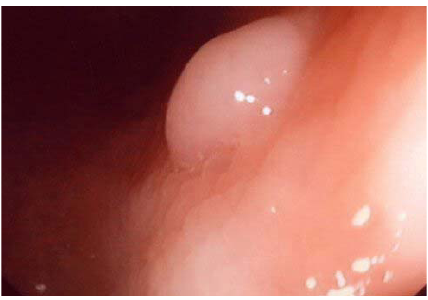
Figure 1. Digestive tract surface showing the specular highlight when illuminated by a light source from a certain